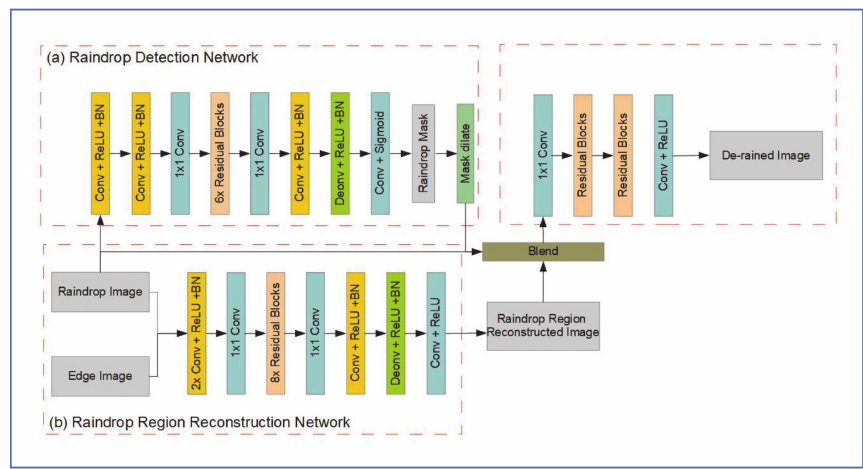
Figure 23. The Structure of the End-to-End Raindrop Removal CNN, proposed by Hoa et al.